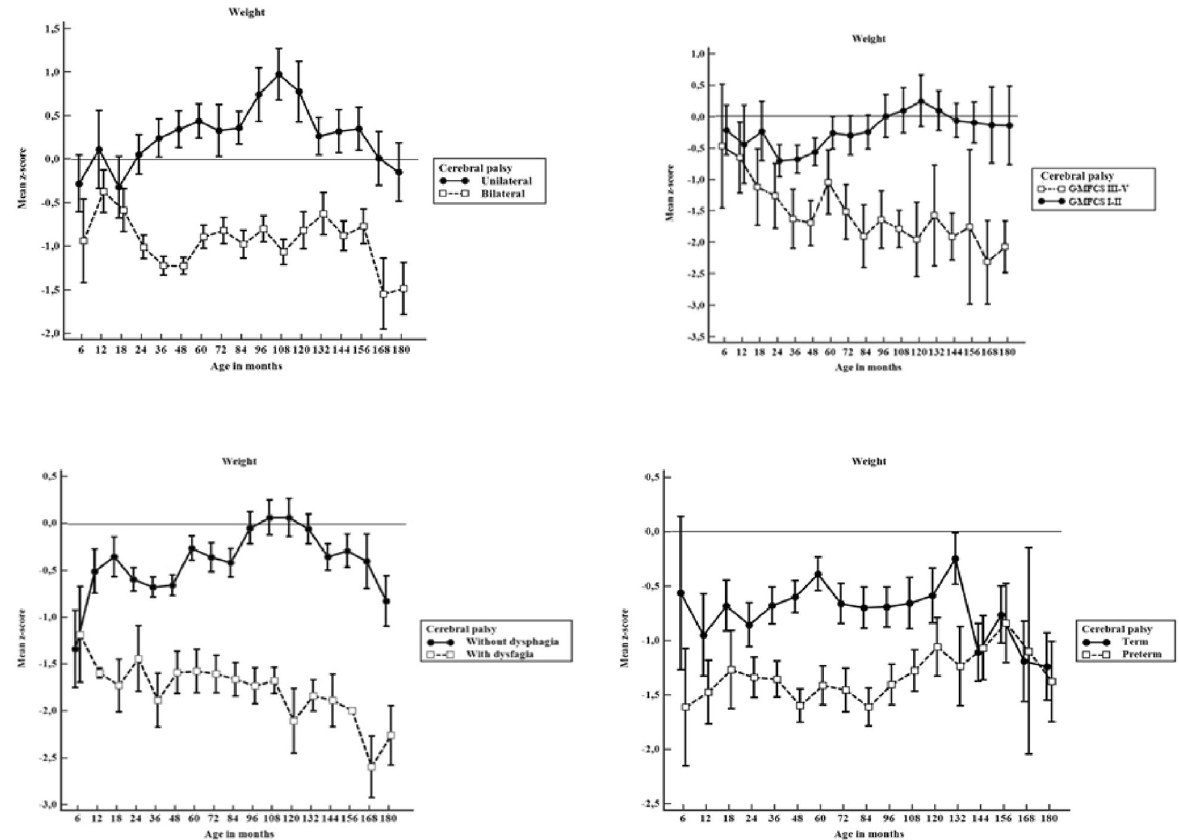
Figure 2. Weight-for-age mean z-scores with 95% CI for weight by age in months among children unilateral vs. bilateral cerebral palsy, Gross Motor Function Classification System level I–II vs. level III–V, with and without dysphagia, and with and without prematurity (n = 1536). If the 95% CI bars overlap, the difference between the two z-score means is not statistically significant (p > Considering GMFCS, children with levels I–II had near to normal BMI gain with means of z-scores of BMI-for- age of between − 0.5 to 0.5, whereas children with levels III–V had a significantly lower BMI (p < 0.001). Premature children with CP were not significantly different in BMI from term children with CP from 6 to 180 months (p > 0.05). Children with dysphagia had significantly lower mean BMI z-scores than children without this disorder, (p < 0.001). Multivariate analysis. Height. In the main effect model, children with bilateral CP, GMFCS level III–V and dysphagia were significantly shorter than children with unilateral CP. Prematurity was not significantly as- sociated with poor height growth in children with bilateral CP compared with children with unilateral CP. In the interaction effect model, children with bilateral CP and GMFCS level III–V were − 0.943 [− 1.129; − 0.756] z-score units shorter than children with unilateral CP (p < 0.001), plus − 1.360 [− 2.183 to − 0.537] of the bilateral condition alone, resulting in an overall average decrease of − 2.303 in the height z-score. Children with bilateral CP and dysphagia had − 0.545 [− 0.785; − 0.305] z-score units lower z-score of height-for-age than children with unilateral CP (p < 0.001), and remain significantly shorter compared to their peers (Table 2a). Weight. In the main effect model, children with bilateral CP, GMFCS level III–V and dysphagia were signifi- cantly lighter than children with unilateral CP. Prematurity was not significantly associated with poor weight gain in children with bilateral CP compared with children with unilateral CP. In the interaction effect model, children with bilateral CP and GMFCS level III–V remain significantly lighter than children with unilateral CP, decreasing their weight-for-age z-score − 1.449 [− 10.526; − 0.677] units compared to children with Unilateral CP (p < 0.001). Children with bilateral CP and with dysphagia were lighter, growing − 0.629 [− 1.189; − 0.068] z-score units below their weight-for-age compared to children with unilateral CP (p < 0.001) (Table 2b). Body Mass Index. In the main effect model, children with bilateral CP, GMFCS level III–V and dysphagia had a significantly lower BMI than children with unilateral CP. Prematurity was not significantly associated with poor BMI gain in children with bilateral CP compared to children with unilateral CP.